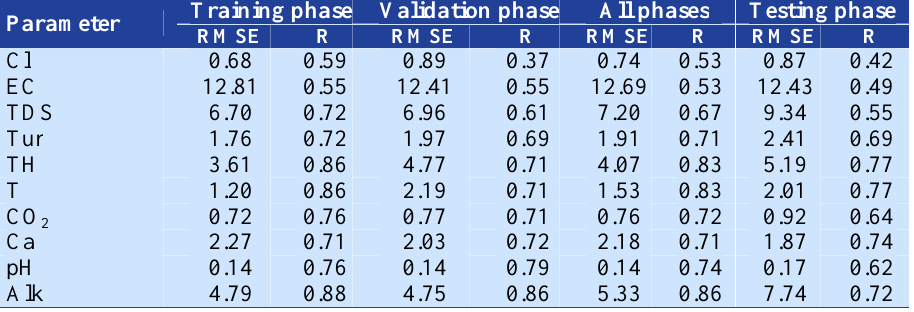
Table 3. Performance of MLP